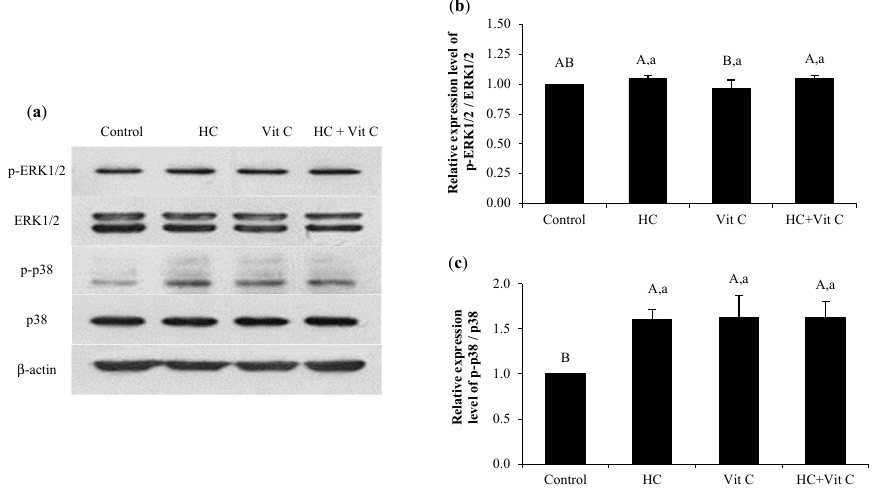
Figure 7. Effect of HC, Vit C, and HC combined with Vit C (HC+Vit C) at the selected levels on the expression of p-ERK1/2 and p-p38 proteins ( a ) and relative level of p-ERK1/2 ( b ) and p-p38 ( c ) in HDF cells after treatment with the samples for 24 h. Bars represent standard deviation ( n = 3 ). Different uppercase letters on bars indicate significant differences between different samples tested and control ( p < 0.05). Different lowercase letters on bars indicate significant differences among different samples tested ( p < 0.05).